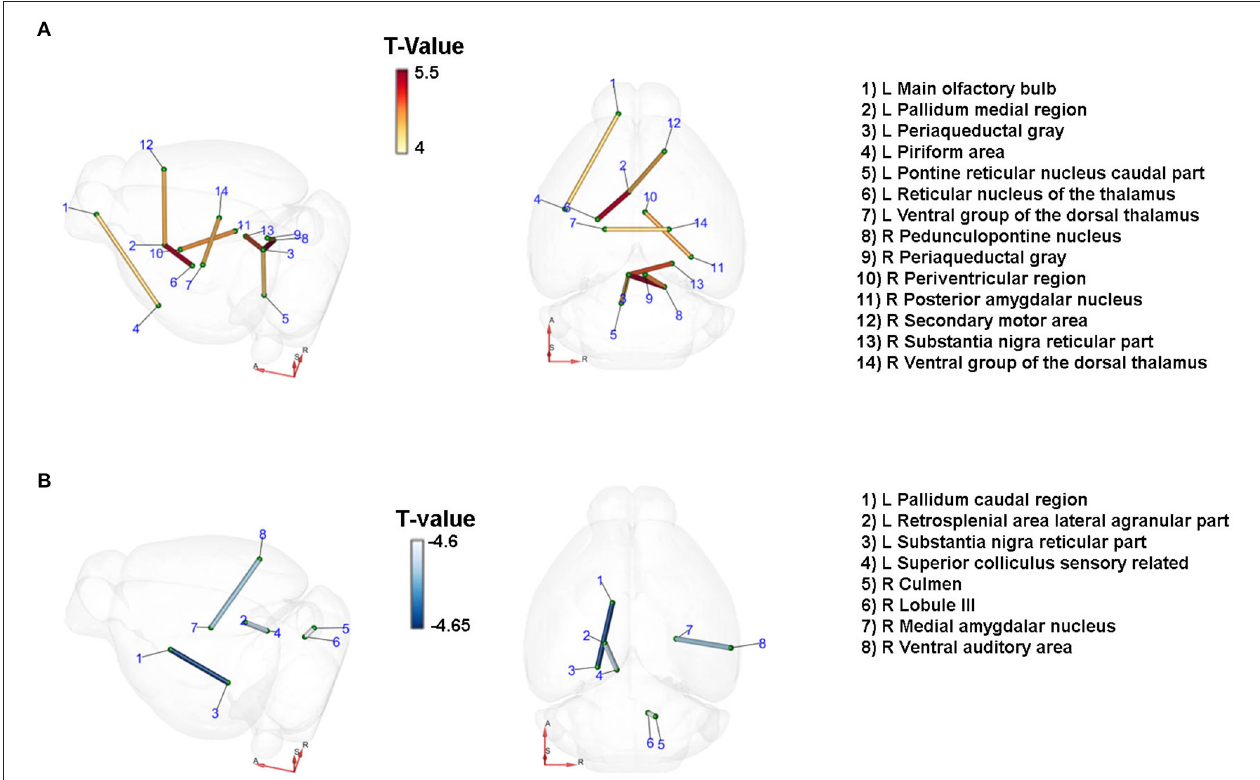
FIGURE 3 | Paracrine IL-6 is a driver of network remodeling after unilateral CCA occlusion. Connections with changes in diffusivity comparing the astrocytic IL-6 ( n = 6) to control animals ( n = 7) at d21 after left CCA occlusion. Coordinates: A = anterior, R = right, S = superior. T-statistics were applied, and all values with p < 0.001 were chosen as relevant. Connections were verified by cross-checking to the Janelia Neuron Browser or Allen Brain Mouse Connectivity Explorer. (A) Nine connections showed an increase in connectivity. Of those, four were inter-hemispheric connections. Especially connections to the ipsilateral periaqueductal gray increased along with the axis from the contralateral secondary motor cortex to the ipsilateral pallidum and subsequently the thalamus. (B) Four connections showed decreased connectivity. On the ipsilateral side, the caudal pallidum and the reticular part of the substantia nigra as well as the connection between the retrosplenial area and the superior colliculus were reduced in strength. On the contralateral side, the connections between the culmen and lobule III and between the medial amygdalar nucleus and the ventral auditory area were decreased.